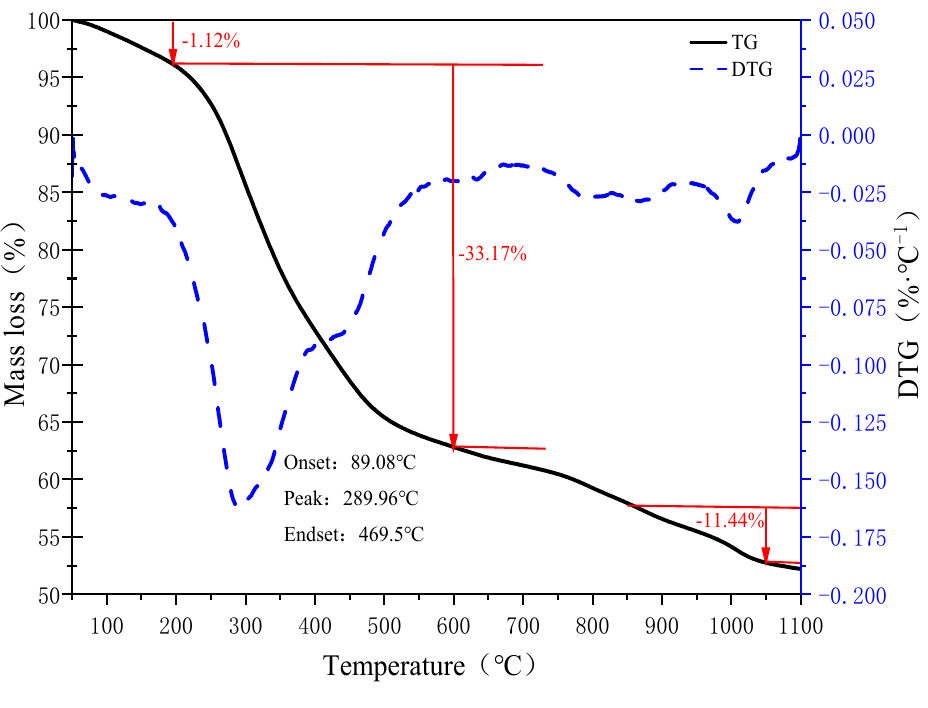
Figure 3. TG-DTG curves of SS.